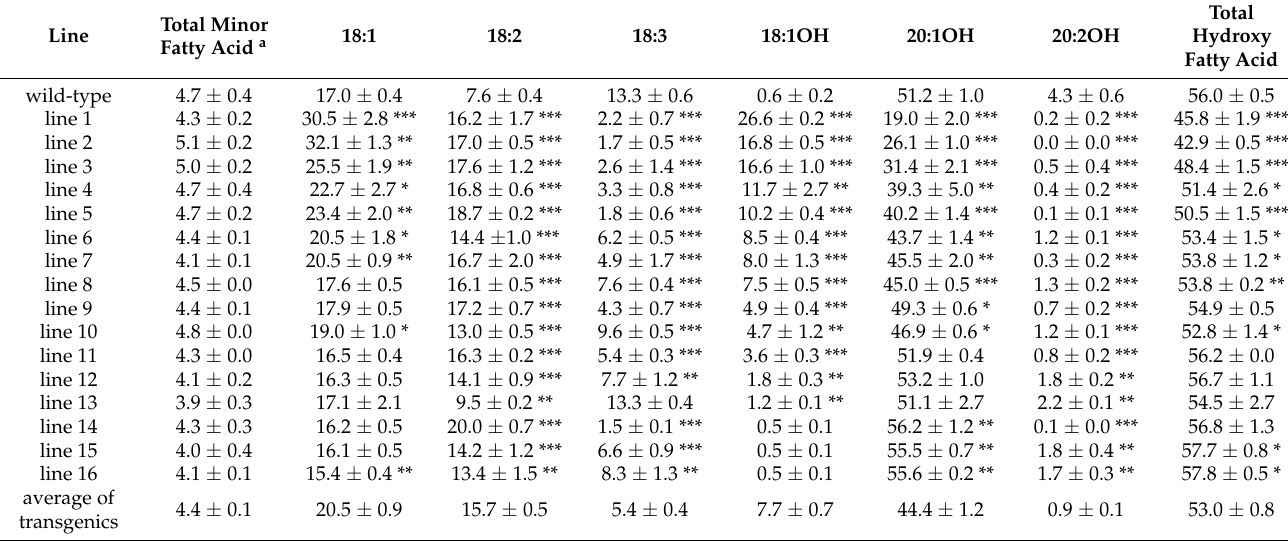
Table 1. Fatty acid composition (mole %) in T1 seeds expressing AtFAD3 RNAi + CsFAE1